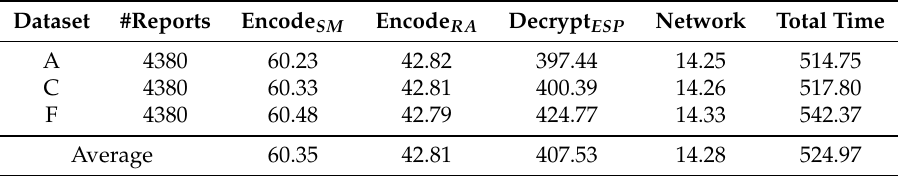
Table 3. Breakdown of execution time of the reporting stage